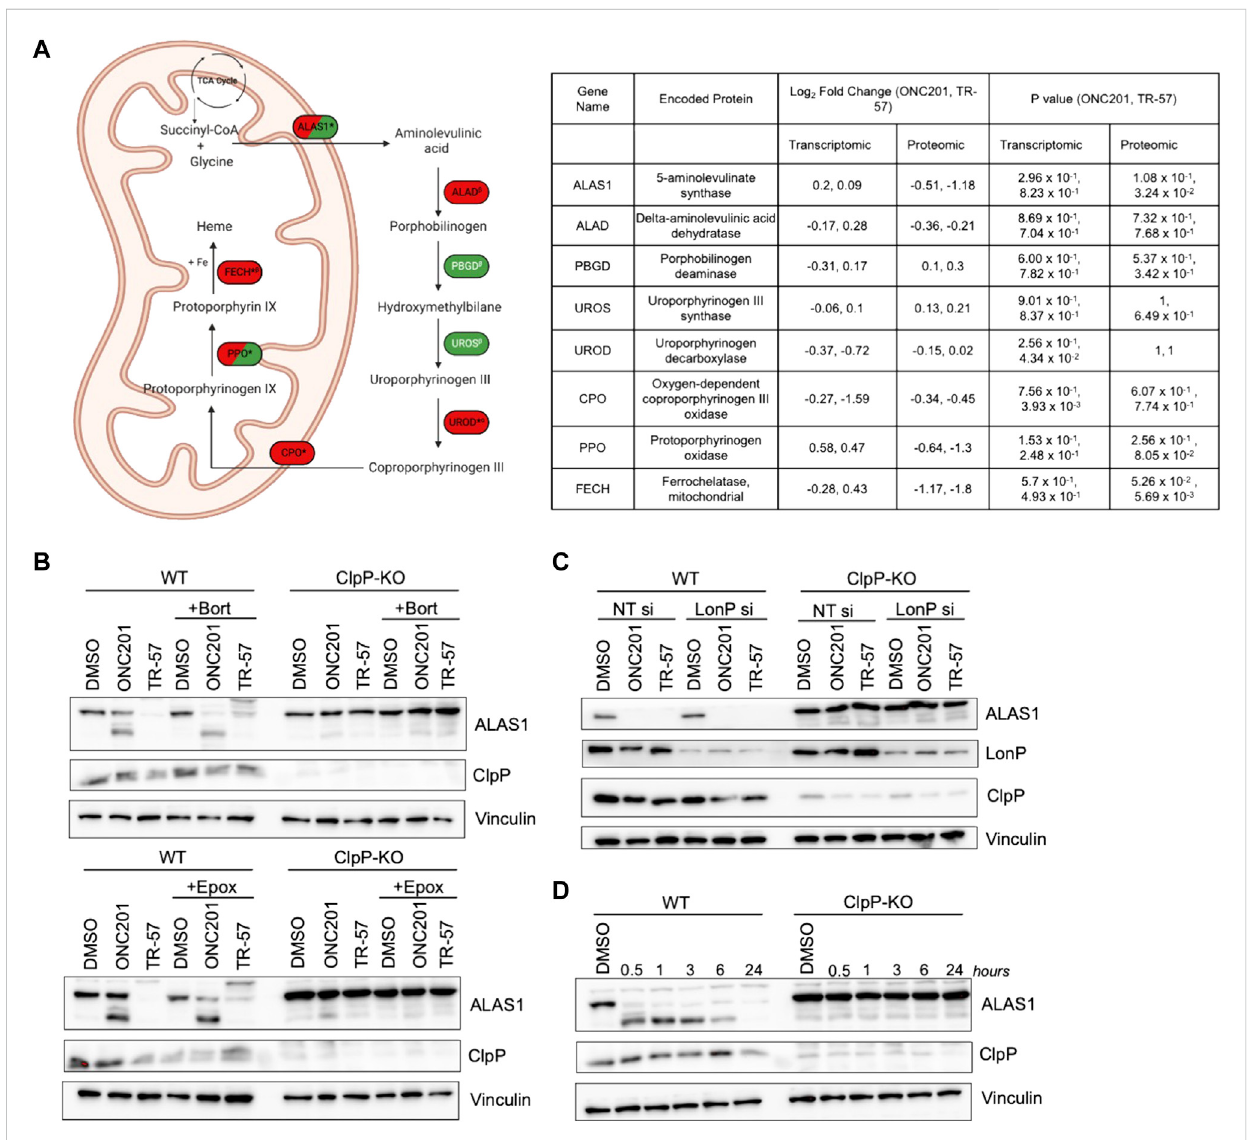
ClpP activation induces loss of major components of the heme biosynthetic pathway in TNBC cells. (A) Schematic of heme biosynthetic pathway (left).Directionalityofchangeisindicatedbycolor(downregulation(red),upregulation (green),notdetected(white)). *indicatessigni fi cantinatleastone dataset, con fl icting α proteomic, β transcriptomic,or Δ both datasetsfor one treatment. δ Notdetected inTR-57 proteomics dataset. Dual-coloredenzymes represent those with different directional changes in proteomics (left side) and transcriptomics (right side) while dual-colored metabolites indicate different directional changes in ONC201 treatment (left side) and TR-57 treatment (right side). ALAS1: 5 ′ - aminolevulinate synthase 1 ; ALAD: aminolevulinate dehydratase ; PBGD: porphobilinogen deaminase ; UROS: uroporphyrinogen III synthase ; UROD: uroporphyrinogen decarboxylase ; CPO: coproporphyrinogen oxidase ; PPO: protoporphyrinogen oxidase ; FECH: ferrochelatase . WT and ClpP-KO SUM159 cells were immunoblotted for ALAS1 following 24 h of 10 μ M ONC201 or 150 nM TR-57 fi n the presence or absence of (B) 10 nM bortezomib (Bort) or 1 μ M epoxomicin (Epox) or